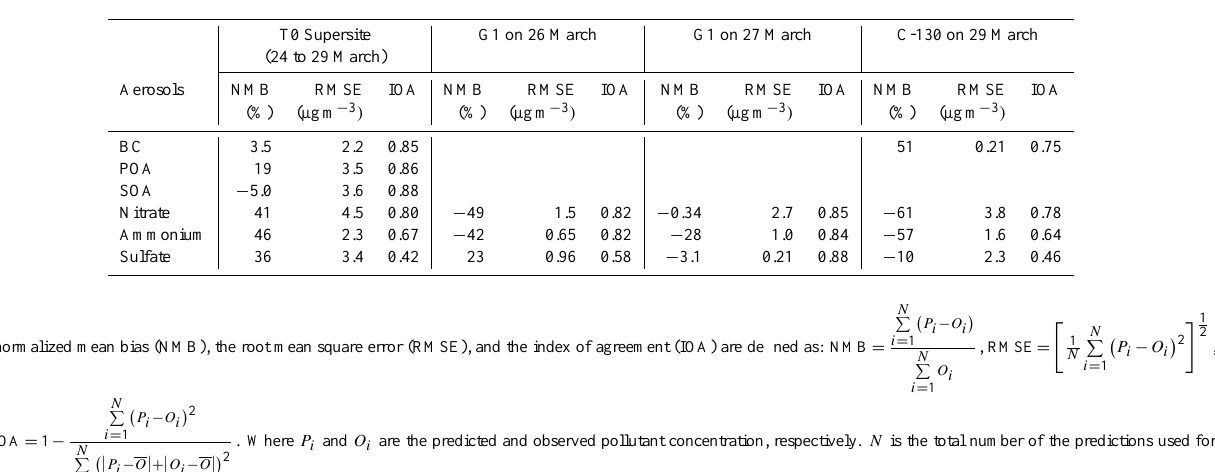
Table 2. Statistical comparisons of simulated and measured aerosol concentrations at T0 and along the flight tracks of research aircrafts (G1 and C-130).